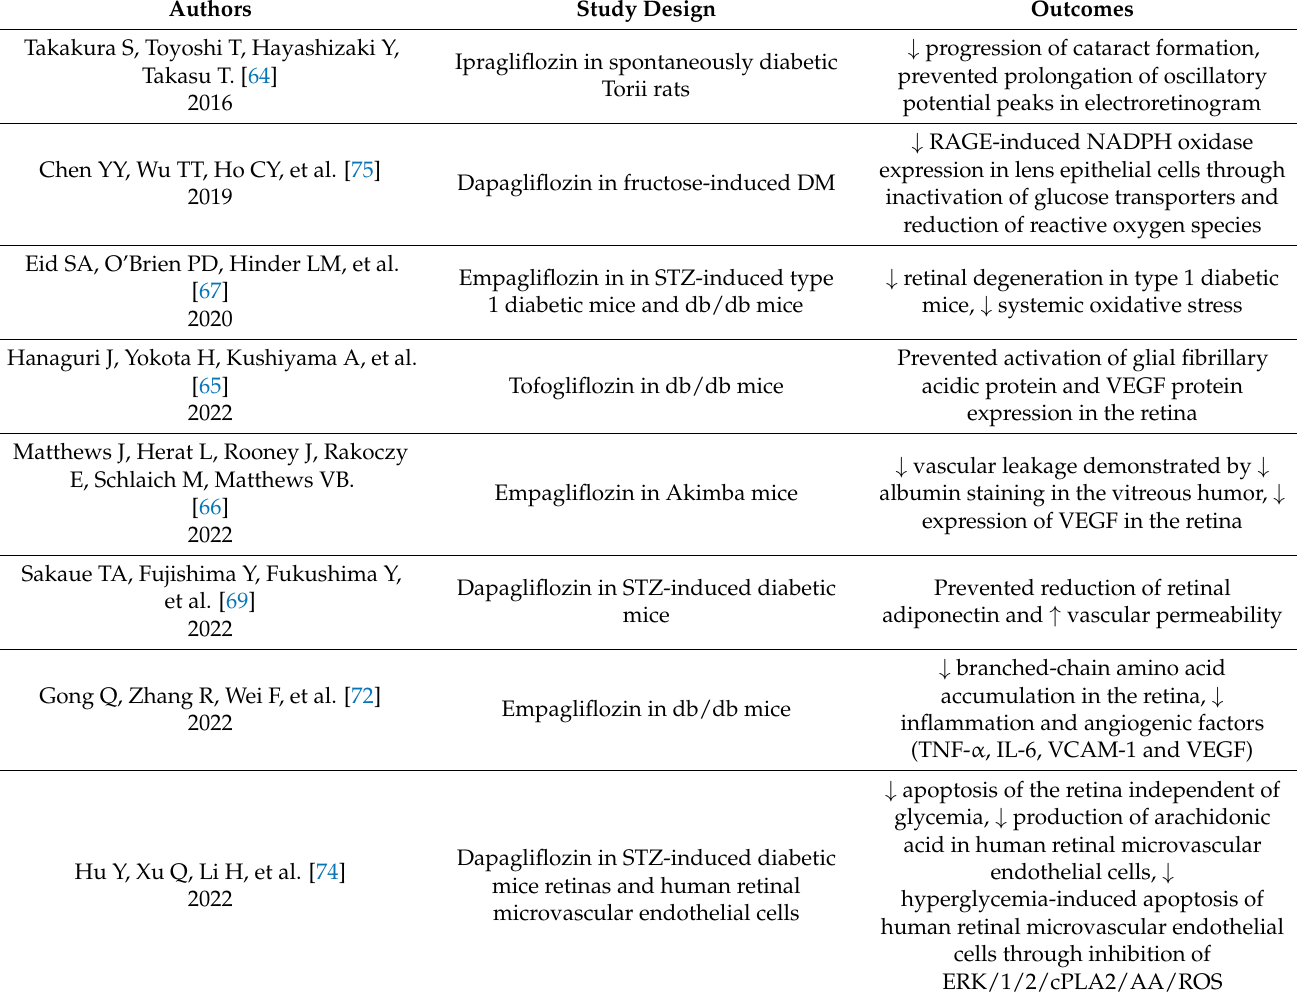
Table 3. Retinoprotective effects of SGLT-2 inhibitors in pre-clinical